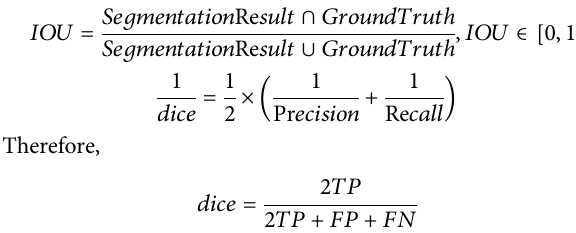
Frontiers in Earth Science |